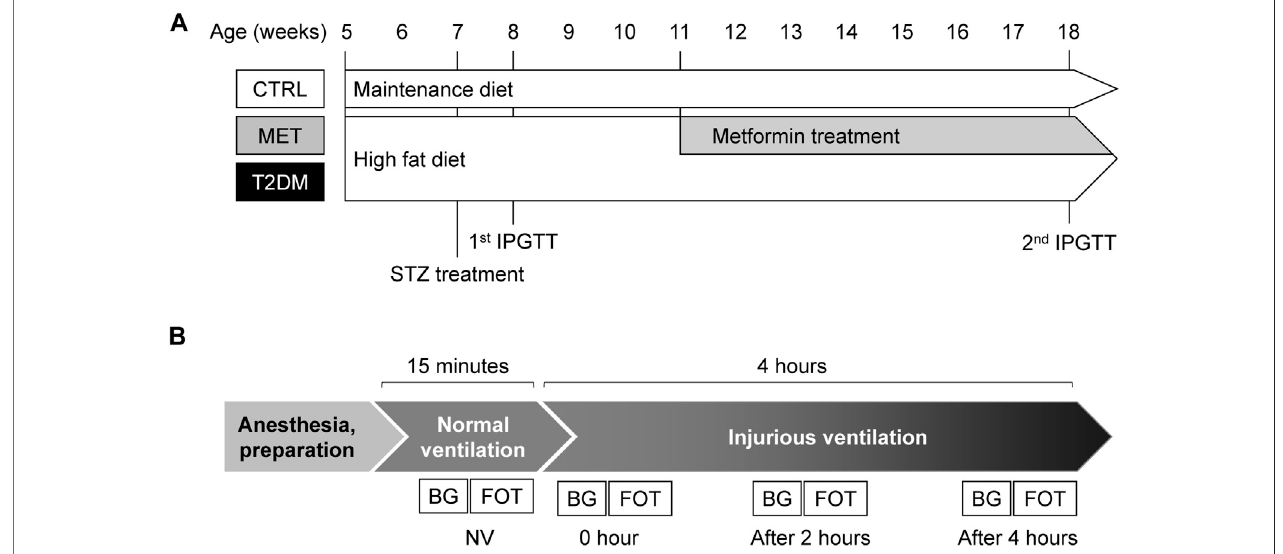
FIGURE1| Schemessummarizingthepretreatmentperiod (A) andtheexperimentalprotocol (B) .Panel (A) : Five-week-oldratswerefedwithmaintenance(Group CTRL) or high-fat diet (Groups MET and T2DM) for 13 weeks. To model peripheric insulin resistance by lowering the serum insulin level, intraperitoneal streptozotocin (STZ) was used in the diabetic groups. A week after the injection intraperitoneal glucose tolerance test (IPGTT) was performed to con fi rm diabetes. Metformin treatment was initiated at the age of 11 weeks for animals in the MET group. The IPGTT was repeated at the end of the pretreatment period to con fi rm the controlled hyperglycemia in the MET group. Panel (B) After the 15-weeks pretreatment period, experiments were conducted under general anesthesia. The mechanical ventilation was initially performed with physiological parameters (NV: 7 ml/kg, PEEP: 3 cmH 2 O and 55 – 60/min frequency), followed by injurious ventilation (23 ml/kg, PEEP: 0 cmH 2 Oand 25 – 30/min frequency). The forcedoscillation measurements(FOT)and blood gasanalyzes were(BG)performedfour times, viz.,at theend oftheNV period and 0, 2, and 4 h during injurious ventilation. Abbreviations: CTRL, control group; MET, metformin-treated model of type 2 diabetes; T2DM, untreated model of type 2 diabetes; STZ, streptozotocin; IPGTT, intraperitoneal glucose tolerance test; NV, volume-controlled ventilation with physiological parameters; FOT, forced oscillation measurements; BG, blood gas